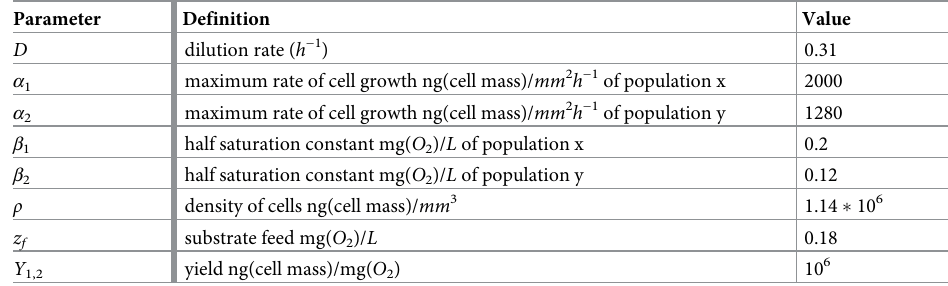
Table 2. Numerical simulation